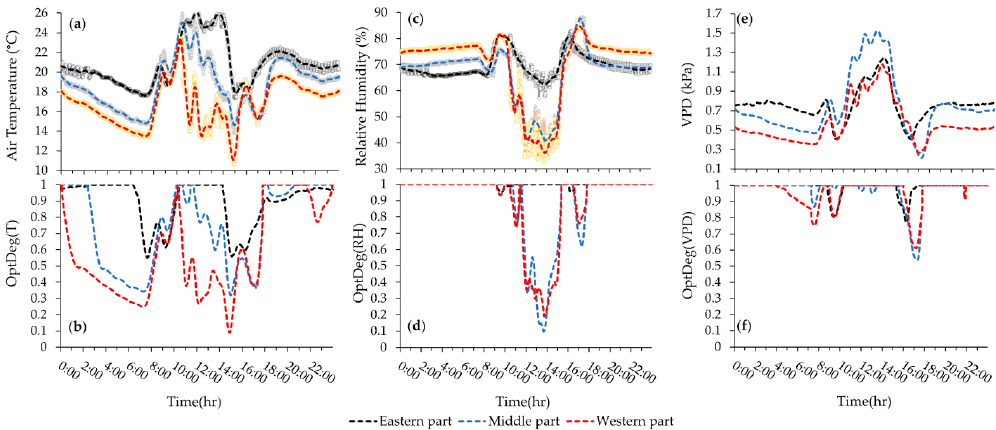
Figure 9. Hourly average variations of microclimate parameters and OptDeg at 17 January 2018. ( a ) air temperature; ( b ) OptDeg(T); ( c ) relative humidity; ( d ) OptDeg(RH); ( e ) vapor pressure deficit and ( f ) OptDeg(VPD). Sensors 2020 , 20 , x FOR PEER REVIEW 18 of 32